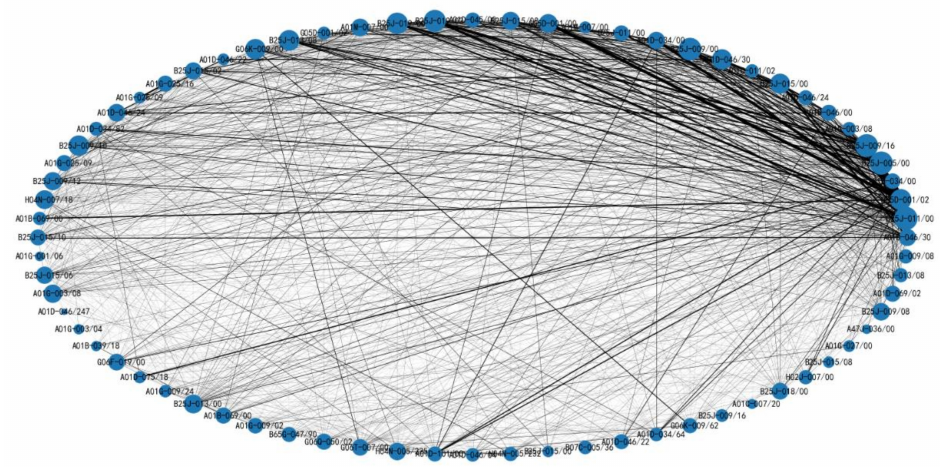
Figure 8. IPC co-classification network (IPCNet) of the agricultural robot